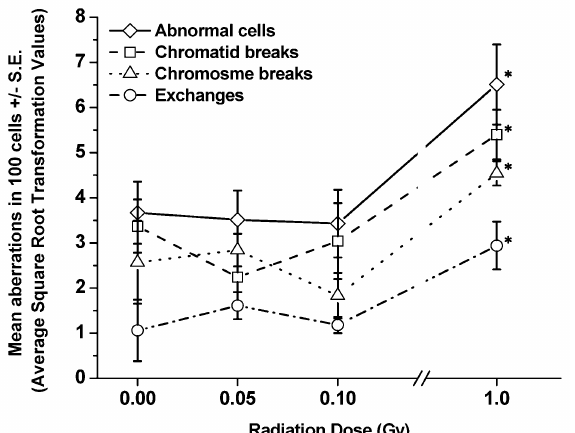
Figure 4. Frequencies of each type of aberration per 100 cells scored (±S.E.) detected